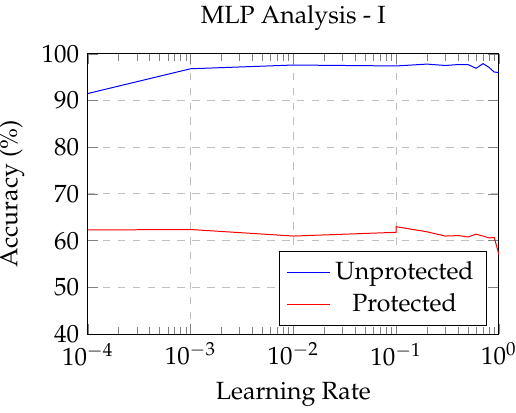
Figure 12. Impact on accuracy of Learning Rate on MLP model.